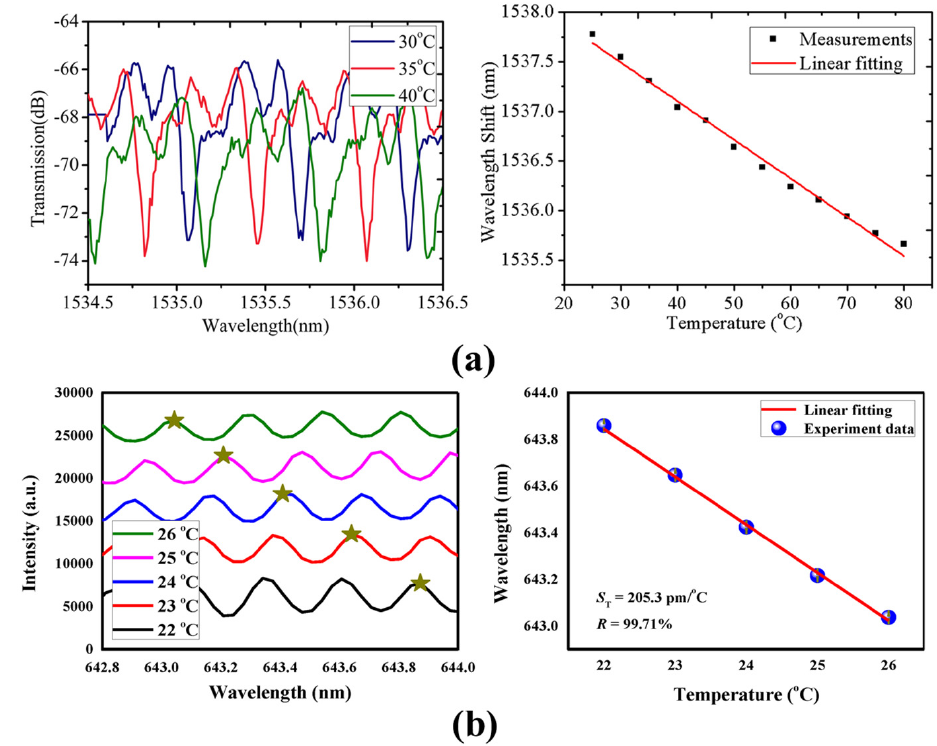
Figure 7. Temperature sensing with WGM microbubble resonators based on: ( a ) PMMA microbubbles (reprinted with permission from [108], © IOP Science), ( b ) encapsulated quasi-droplet microbubbles (reprinted with permission from [117], © CC BY license).